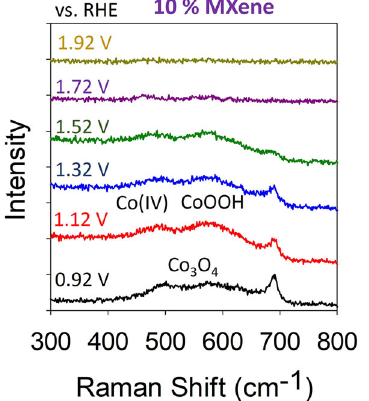
Fig. 8 Further OER active site investigation. Raman spectra for the 10% Raman catalyst from the potentials of 0.92 – 1.92 V vs.